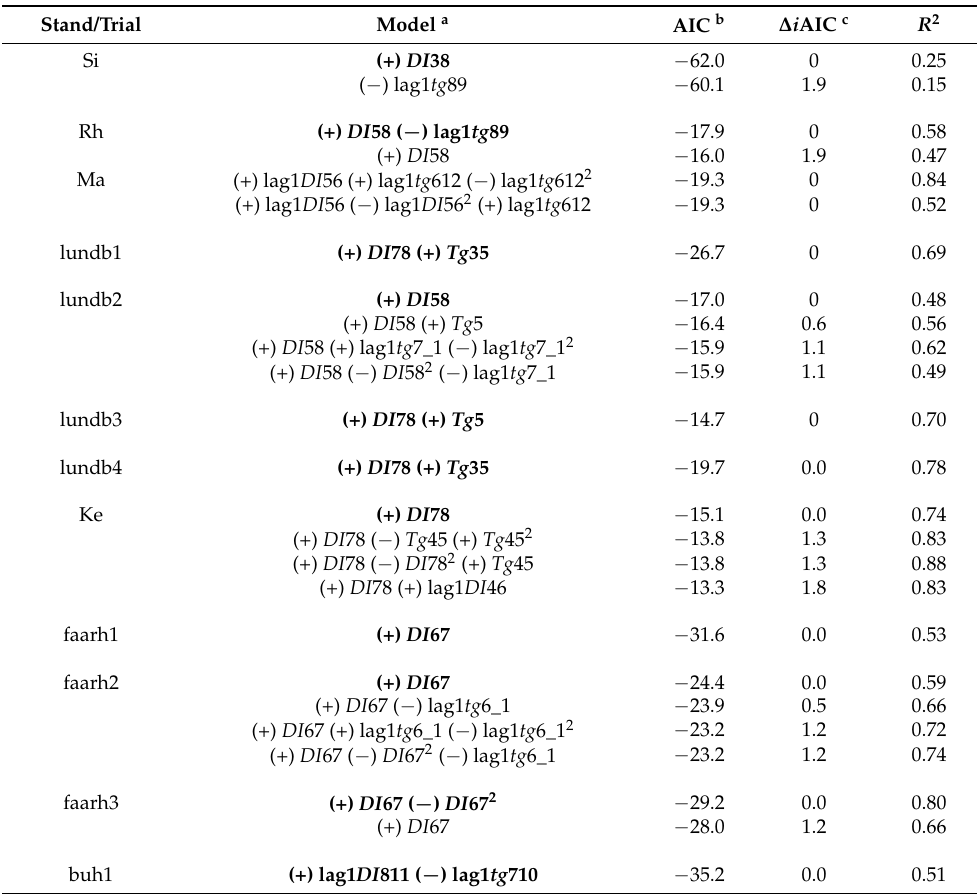
Table 2. Overview of the selected best multi-regressed climate-growth models fitted to each studied Norway spruce